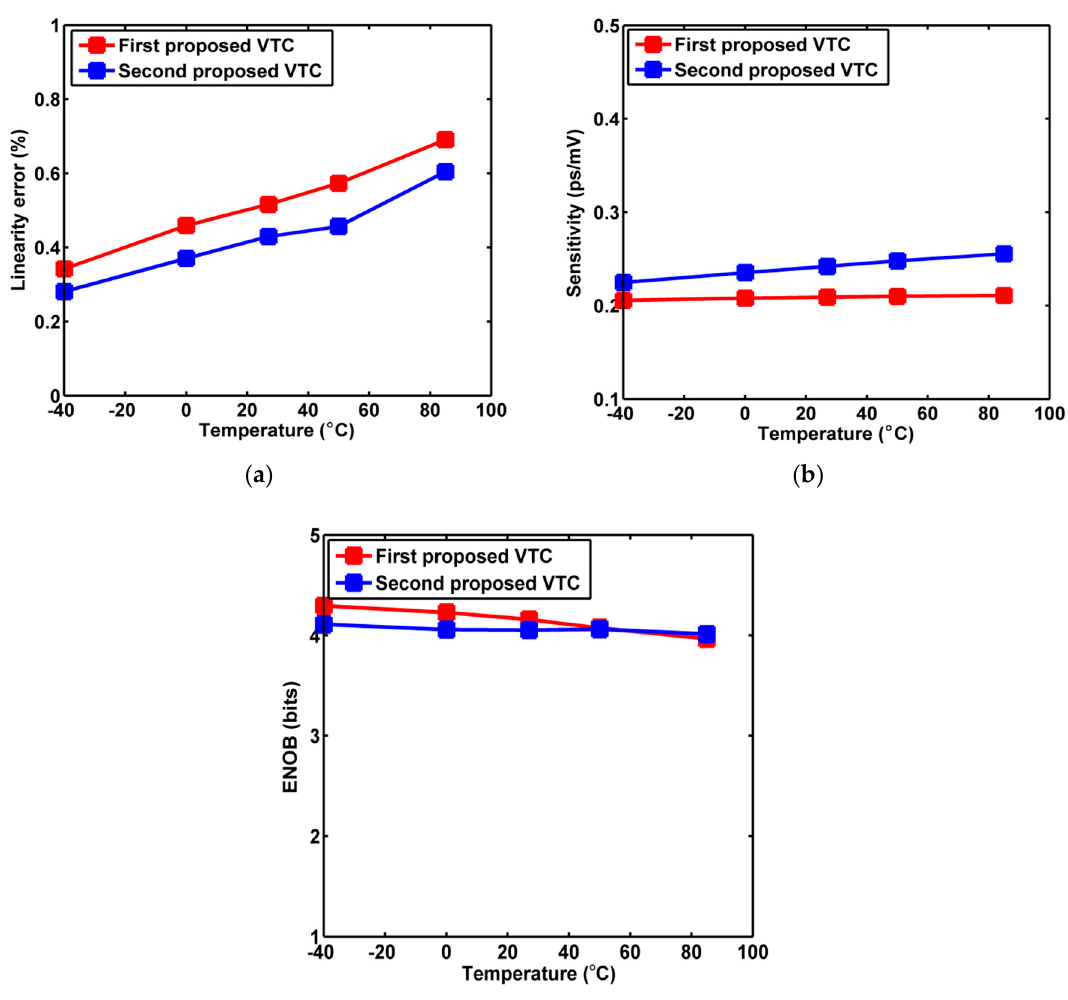
Figure 20. ( a ) Maximum linearity error versus temperature for the proposed VTCs, ( b ) sensitivity versus temperature for the proposed VTCs and ( c ) ENOB versus temperature for the proposed VTCs.